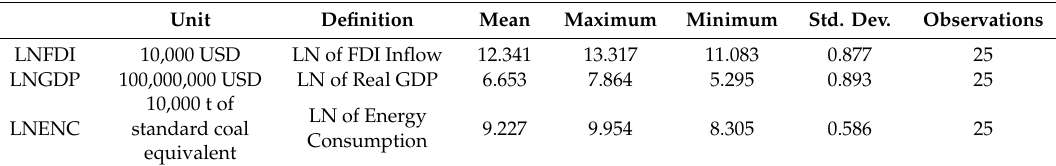
Table 3. Summary statistics.